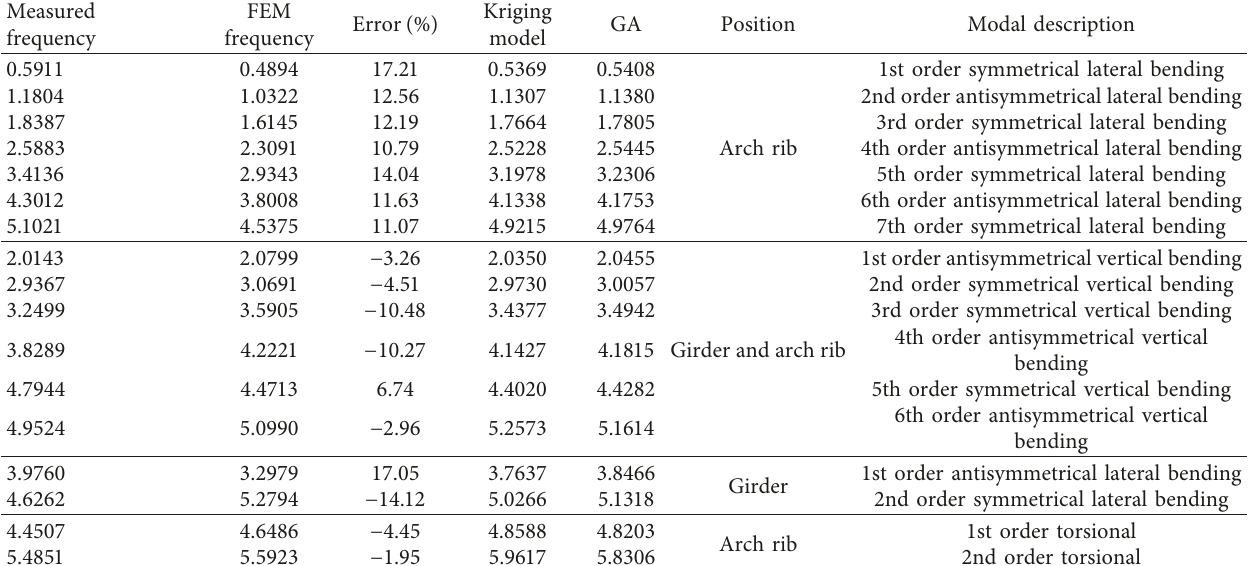
Table 4: Comparison of testing results and FE model results (unit: Hz).